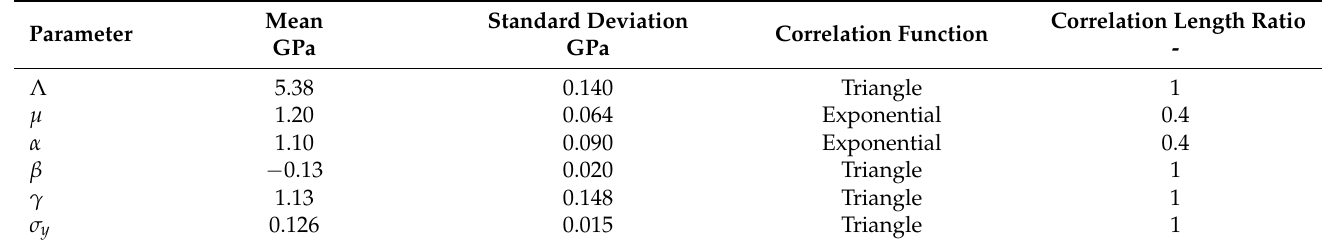
Table 2. Mean values and standard deviations of the strain density function coefficients for a window size of 750µm, taken from